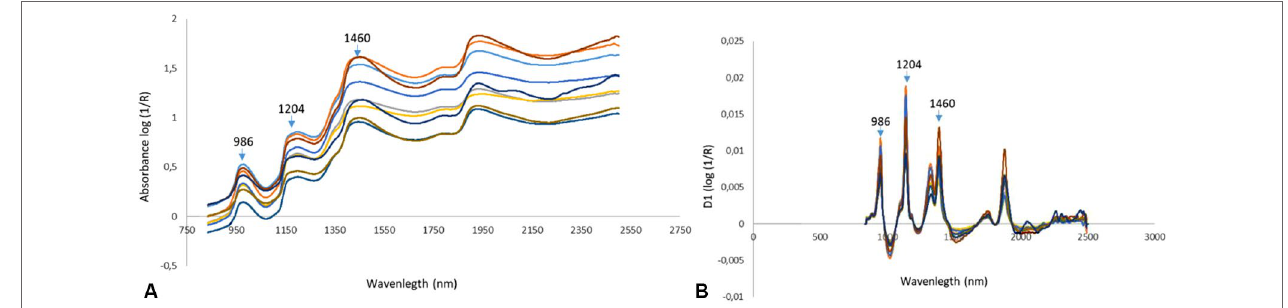
FIGURe 3 | The log (1/R) spectra of intact bunches (A) and spectra of intact bunches after Savitzky-Golay First Derivative (SG1d) spectral preprocessing was applied (B) .